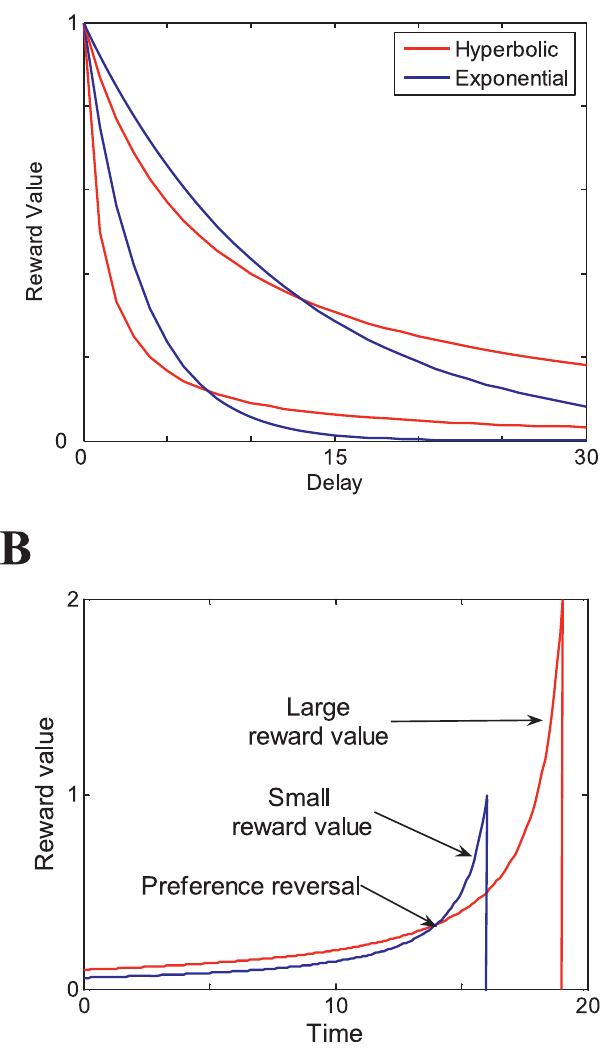
Figure 1. Hyperbolic and Exponential Reward Discounting Models (A) Hyperbolic versus exponential reward discounting models as a function of the delay to the reward for two different sets of steepness parameters. The hyperbolic model has an initial steep decay followed by a flatter ‘‘ tail ’’ ; thus, delayed rewards are less discounted with hyperbolic models than with exponential models. (B) Preference reversal, which is commonly observed in humans and animals, is predicted by the hyperbolic model and is due to a decrease in the decay rate as the delay increases. Initially (at time 0), the large reward has a higher value than the small reward, and is therefore preferred. As the small reward draws near, the preference shifts to the small reward. The exponential model, which has a constant decay rate, does not predict preference and the hyperbolic model (Equations 3 and 4) to the choice data (see Materials and Methods). In each case, two parameters were estimated: c and b , which controls the variability of reward choice, for the exponential model, K and b for the first hyperbolic model (Equation 3), and T and b for the second hyperbolic model (Equation 4). The exponential model fit gave: c ¼ 0.77 6 0.035 SD and b ¼ 7.3 6 2.4 SD. Hyperbolic model fits gave K ¼ 2.6 6 0.94 SD and b ¼ 13.8 6